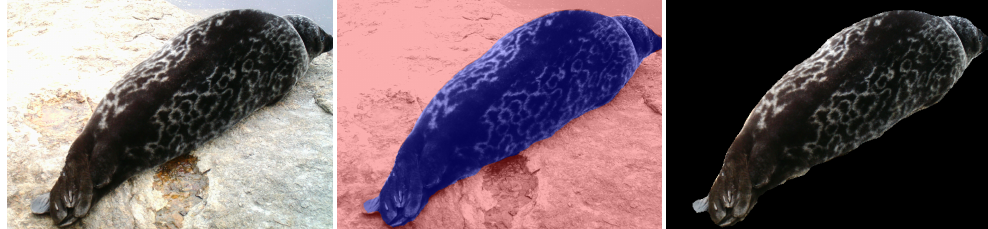
Figure 4. An example of the seal segmentation by using the mask. The original image ( left ), the mask highlighted in blue and the background highlighted in red ( middle ), and the result of the segmentation ( right